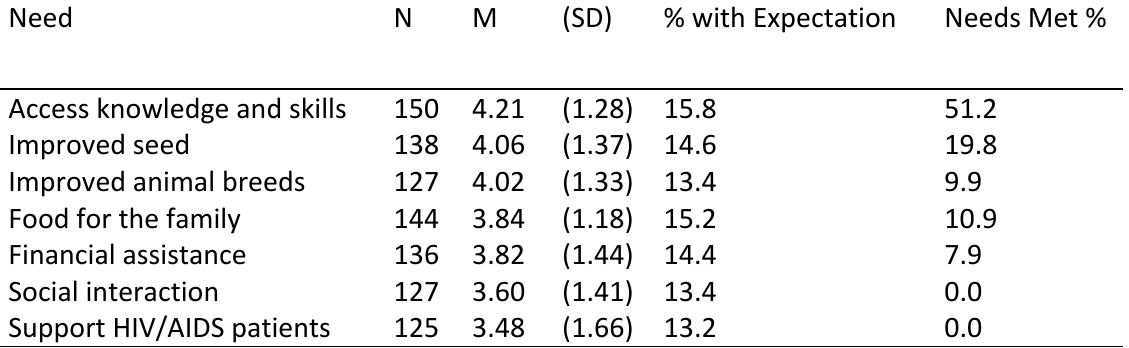
Reasons Member Joined